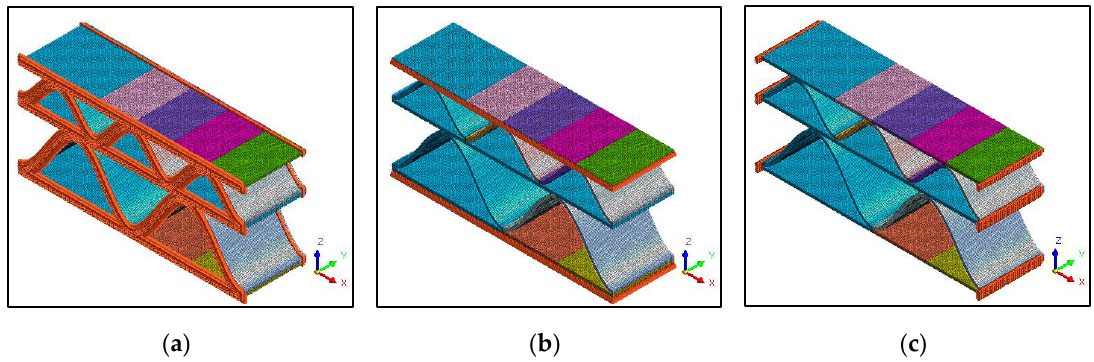
Figure 7. Boundary conditions applied when analyzing reaction force for shear displacement (XY)